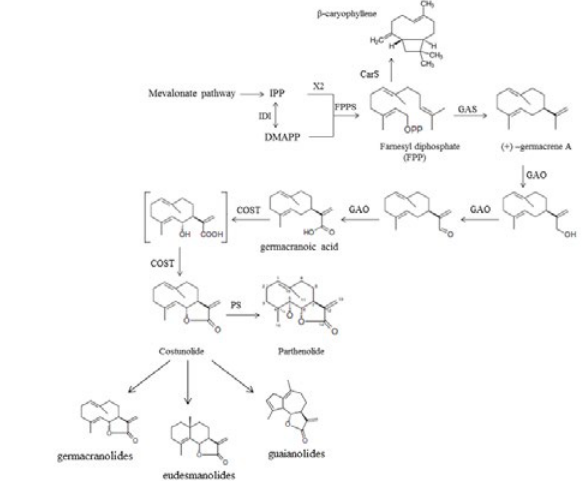
Fig. 3. The suggested biosynthetic pathway for parthenolide and β-caryophyllen synthesis in feverfew (Majdi et al., 2011). CarS: caryophyllen sybthase; GAS: germacrene A synthase; GAO: ger- macrene A oxidase; COST: costunolide synthase; PS: Parthenolide synthase.